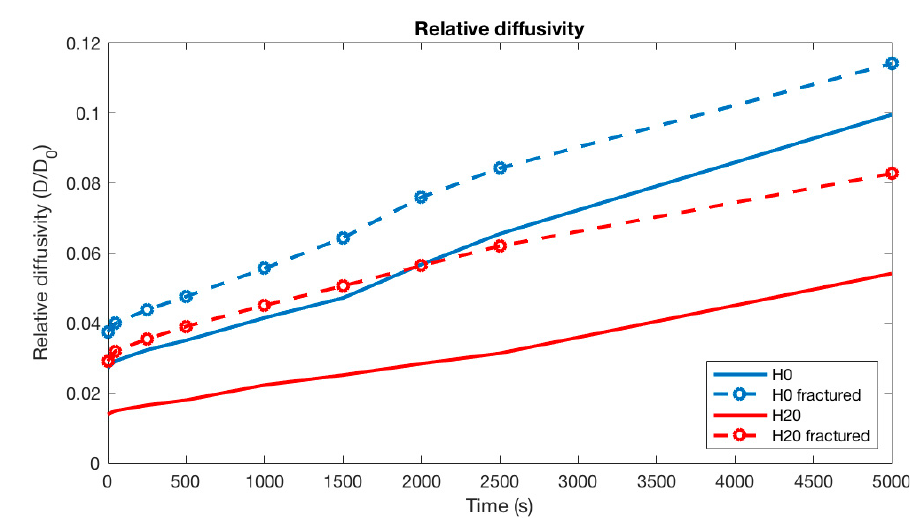
Figure 7. Evolution of the diffusion coefficient during leaching at the scale of 100 µm domain.